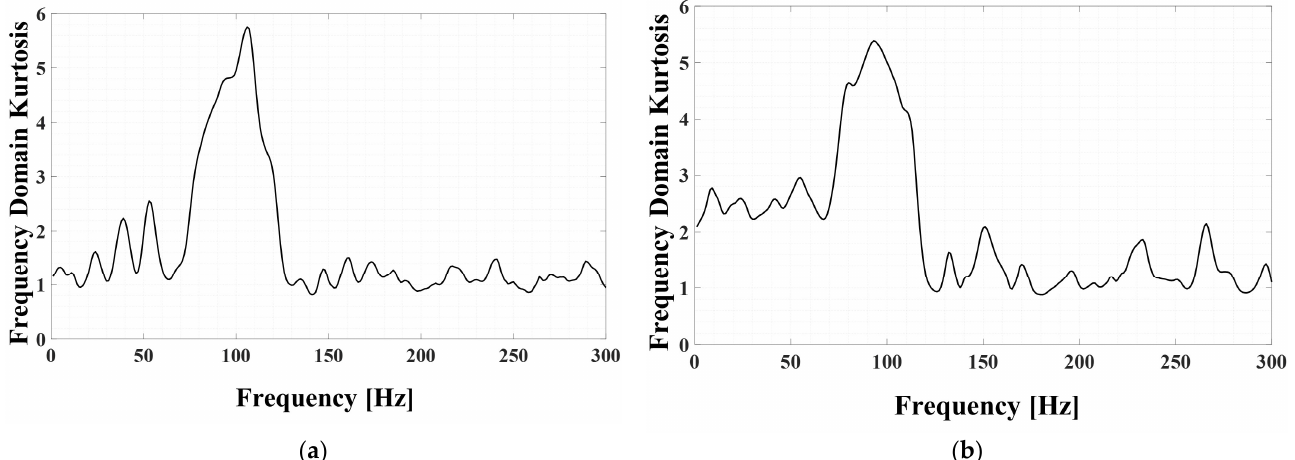
Figure 7. Results of FDK: ( a ) FDK using virtual measurement signal x(t) and ( b ) FDK using virtual measurement signal y(t).